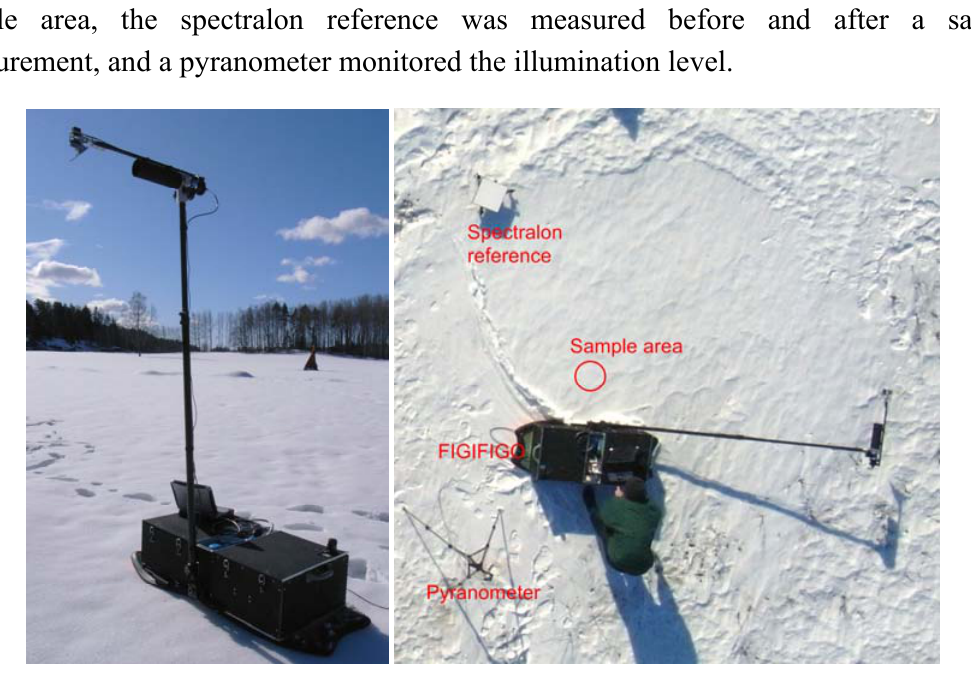
Figure 2. Left: Finnish Geodetic Institute Field Goniospectrometer (FIGIFIGO).